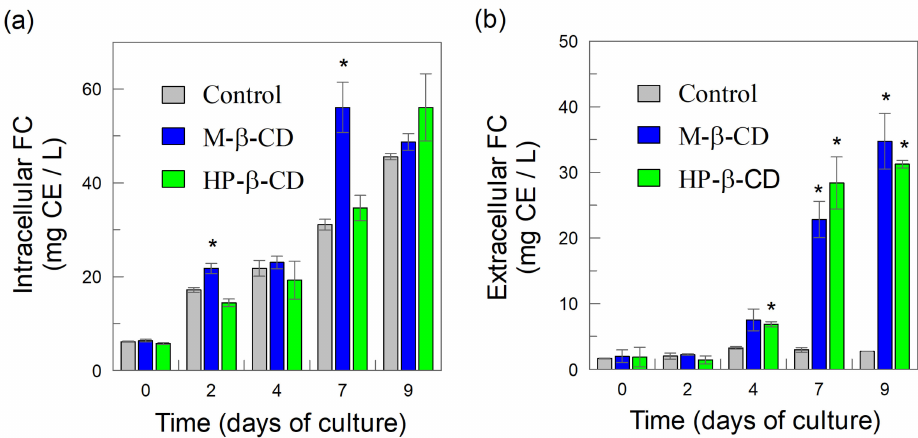
Figure 3. Variation of the intracellular ( a ) and extracellular ( b ) flavonoid content (or production) in non-elicited (control) and cyclodextrin (CD)-treated B. × houghtonii suspension cultured cells (BHSCC) extracts ([CD] = 50 mM) over time. FC production is expressed as total catechin equivalents (CE, mg / L). Values are given as the mean ± SD of triplicates and (*) refers to significant di ff erences between control and treatments for each day ( p <